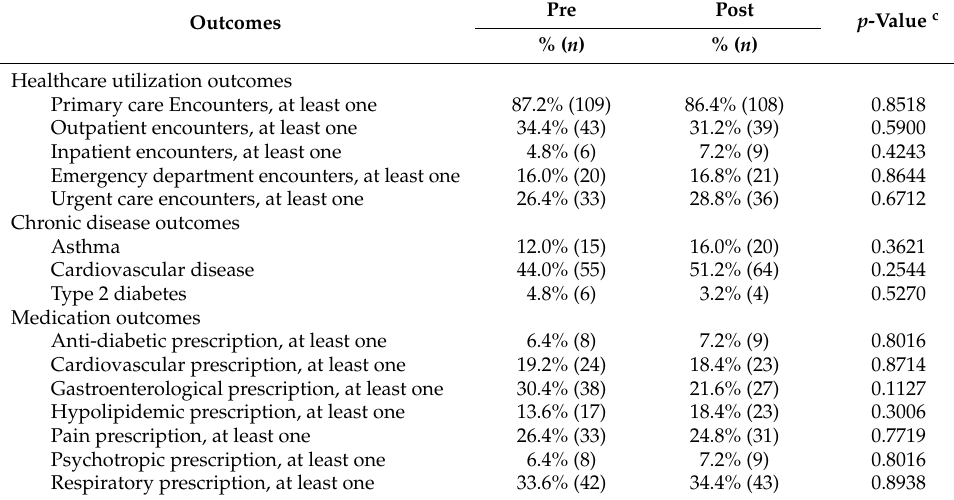
Table 3. Change in participant’s claims-measured healthcare outcomes from 12 months pre- to 12 months post-program enrollment, n = 125 a,b